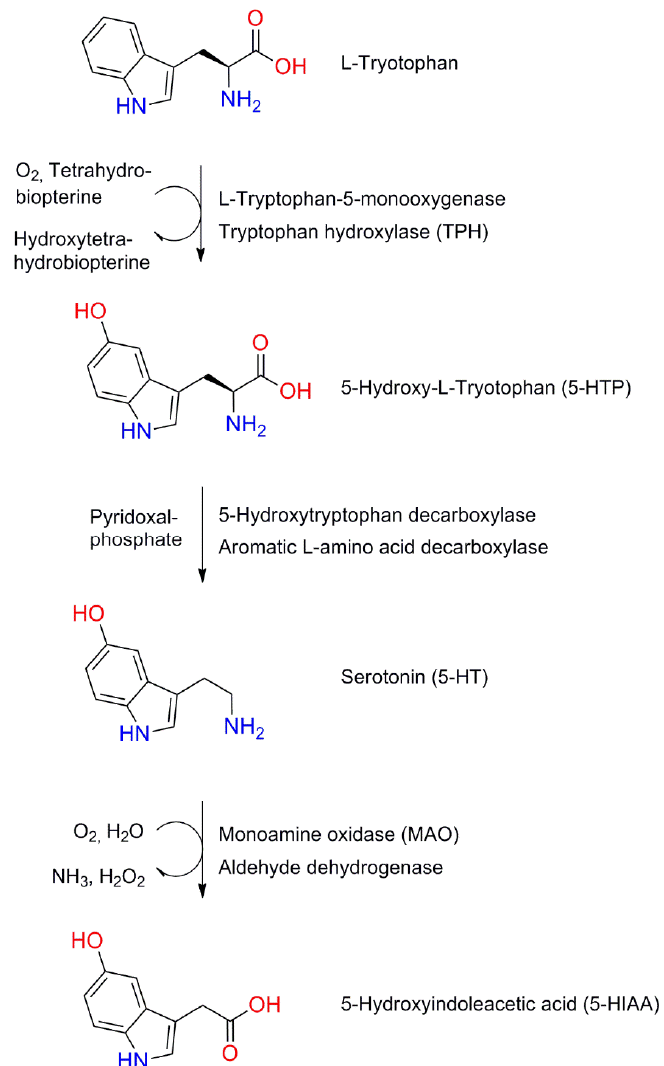
Figure 4. Serotonin synthesis and degradation pathways. In the CNS, serotonergic neurons from DRN and MRN communicate with various areas within the cerebral cortex, limbic system, midbrain, and cerebellum [133]. Serotonin communication occurs mainly through volume transmission (VT) in the extracellular space and the cerebrospinal fluid (CSF). Serotonin travels from the source to target cells (neurons and astroglia) through energy gradients, leading to its diffusion and convection [134]. By interacting with its receptors, 5-HT is responsible for the regulation of many processes important for life, which include perception, mood, anxiety, aggression, cognitive functions, attention, sexual functions, and the circadian rhythm [131,135,136]. 6.2. Serotonin Receptors and Transporters Thirteen G-protein-coupled heptahelial serotonin receptors (5-HTRs) and one ligand-gated ion channel have been identified and are divided into seven distinct classes (5-HT 1–7 ) [132,134]. All 5-HTRs are heteroreceptors associated with the postsynaptic membrane on nonserotonergic neurons. Presynaptically located autoreceptors